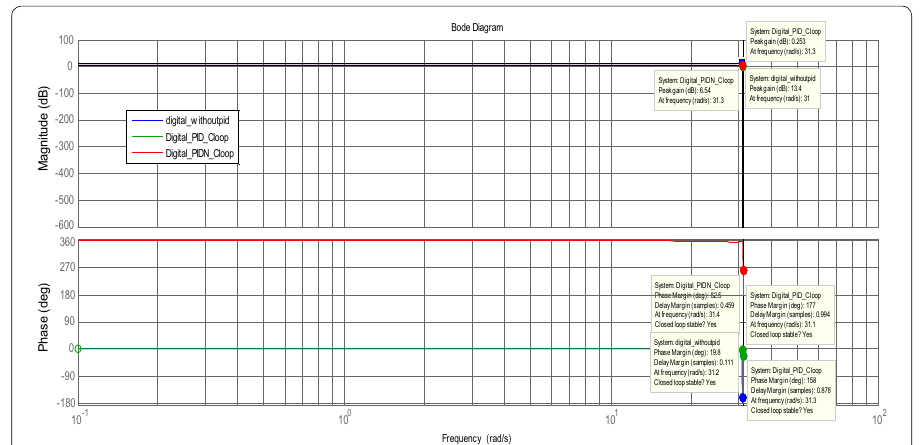
Fig. 10 Digital domain frequency response of BBC with PID and PIDN and without PID control in boost mode